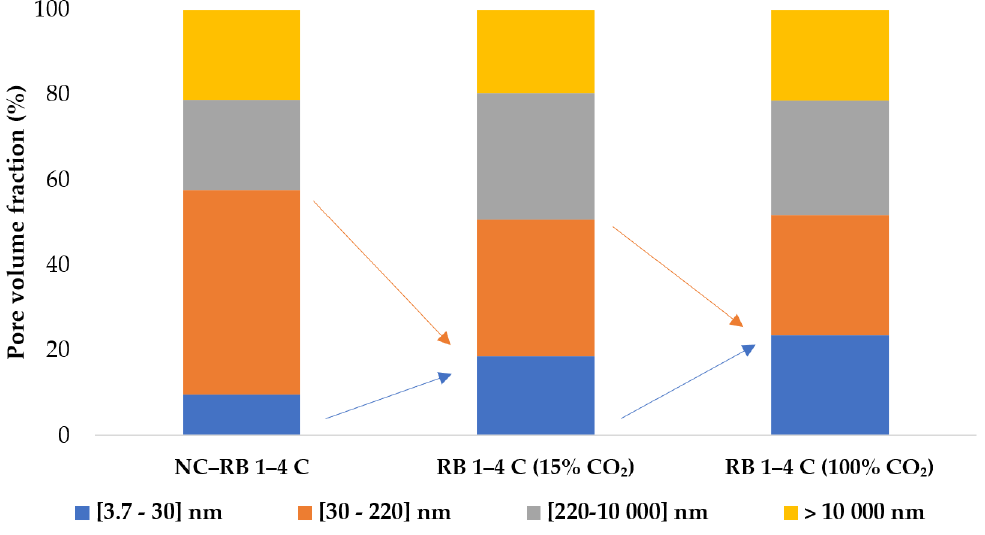
Figure 19. Pore volume